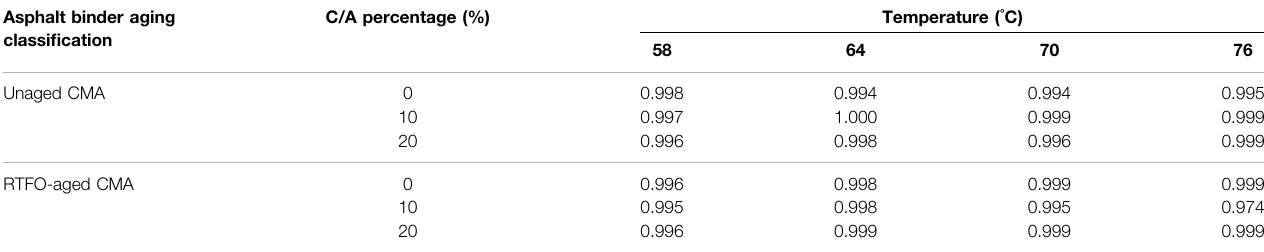
TABLE 3 | Correlation test results between the temperature and C/A percentage variables for the unaged and RTFO-aged CMA binders. Asphalt binder aging classi fi